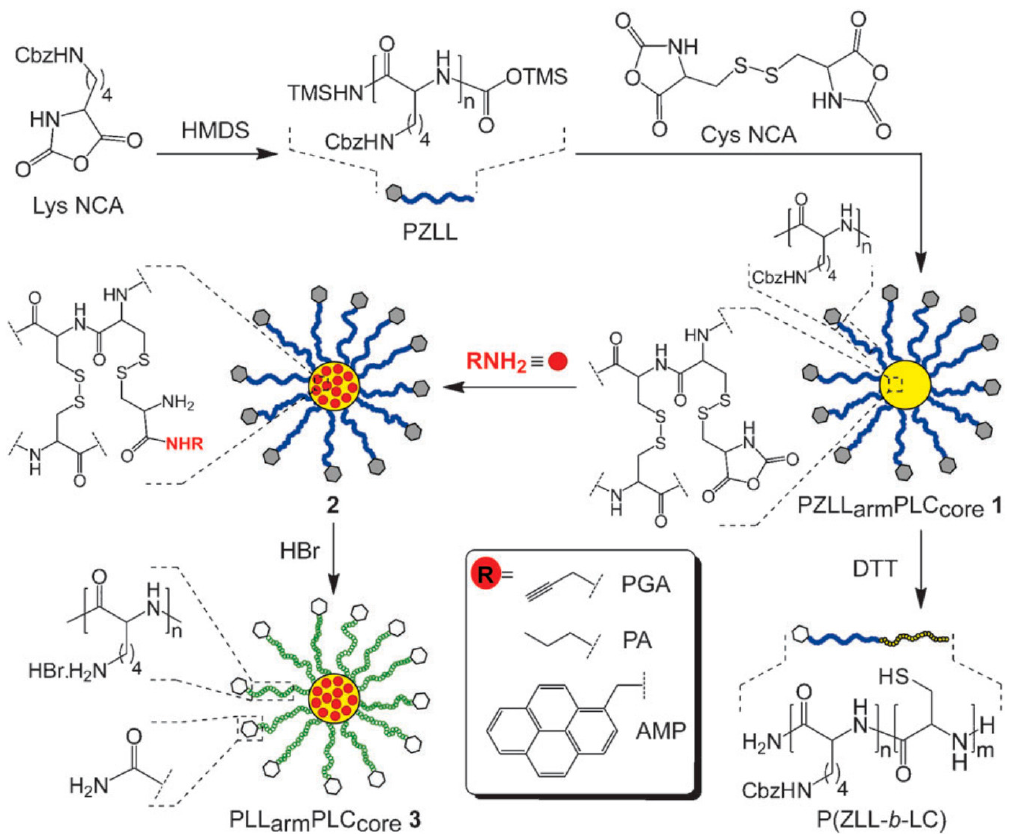
Figure 44. Synthesis of amino acid-based Core Cross-linked Star (CCS) polymers having hierarchical functionalities via a one-pot arm-first strategy. Reproduced with permission from reference [202].